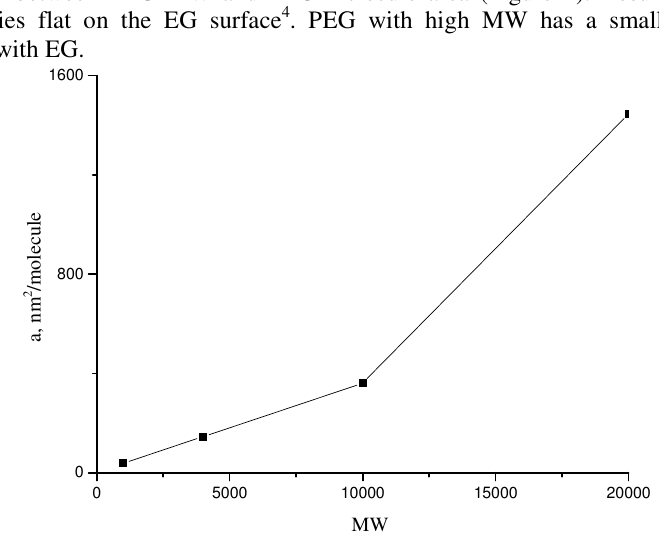
Figure 2. Relationship between PEG MW and molecule